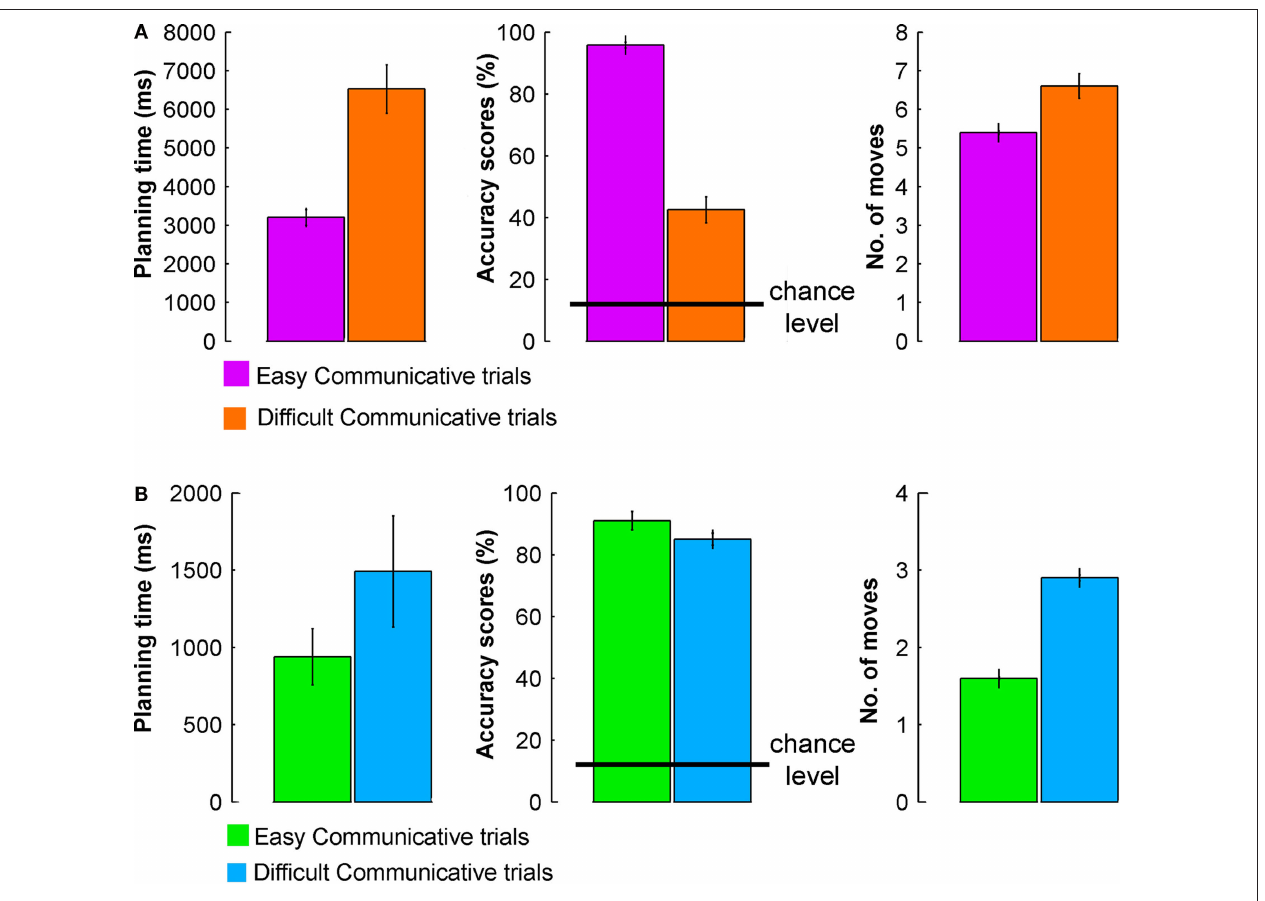
FIGURE 8 | Performance during EASY and DIFFICULT COMMUNICATIVE trials – behavioral data for the fMRI experiment. (A) Planning times (ms), accuracy scores (%), and number of moves of the sender for EASY COMMUNICATIVE